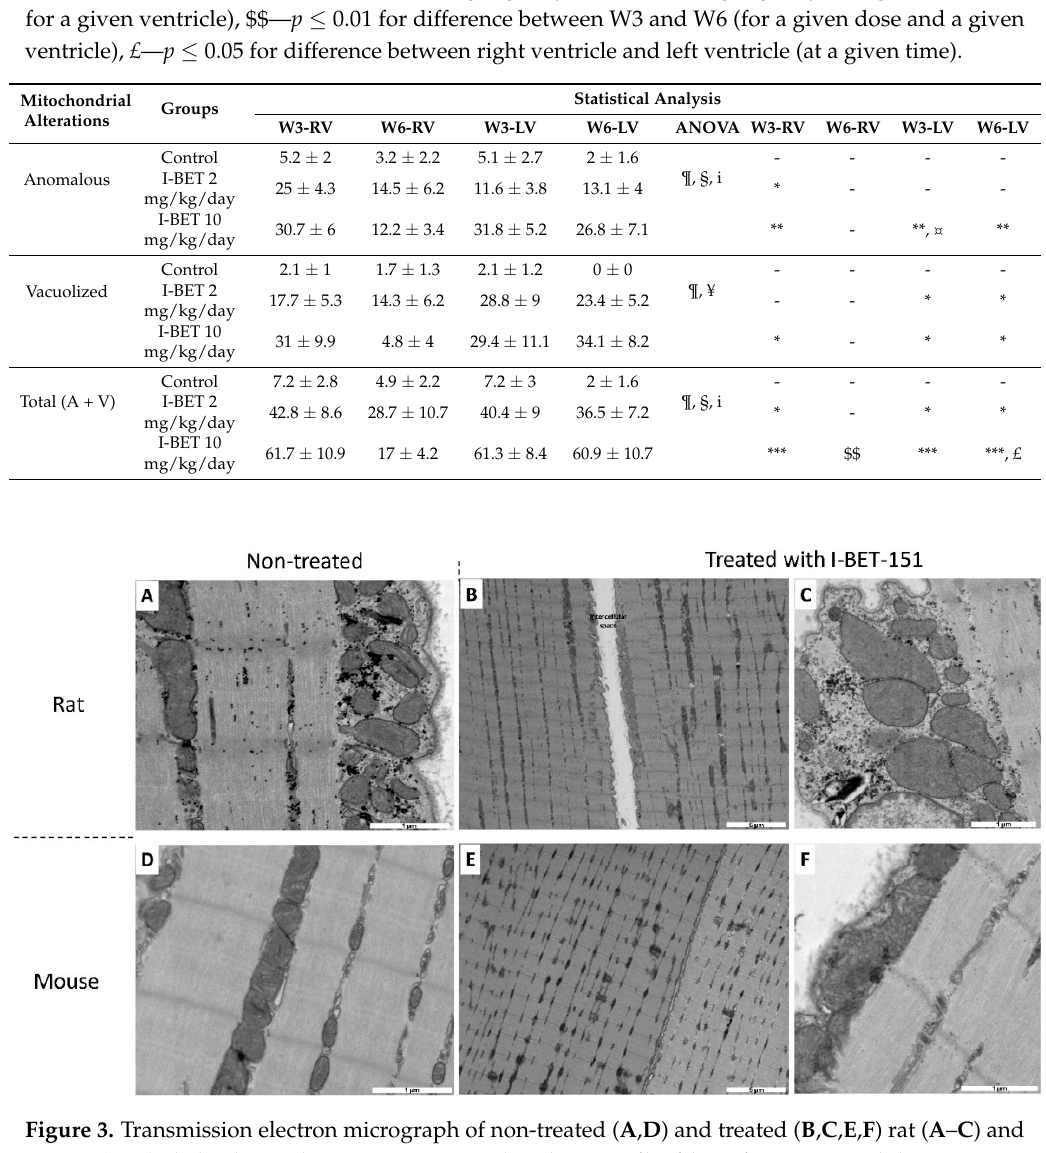
Table 1. Proportion of altered mitochondria amongst total mitochondrial population. Altered mitochondria were mitochondria with anomalies (A) or vacuoles (V). The sum of mitochondria with anomalies and mitochondria with vacuoles represents the totality of altered mitochondria (Total). Statistical analysis: multifactorial ANOVA. ¶— p ≤ 0.05 for the dose effect; §— p ≤ 0.05 for the washout effect; ¥— p ≤ 0.05 for the ventricle effect; i— p ≤ 0.05 for the interaction effect. Post hoc Newman–Keuls test: * p ≤ 0.05, ** p ≤ 0.01, *** p ≤ 0.001 for difference versus the control group (at a given time and for a given ventricle),